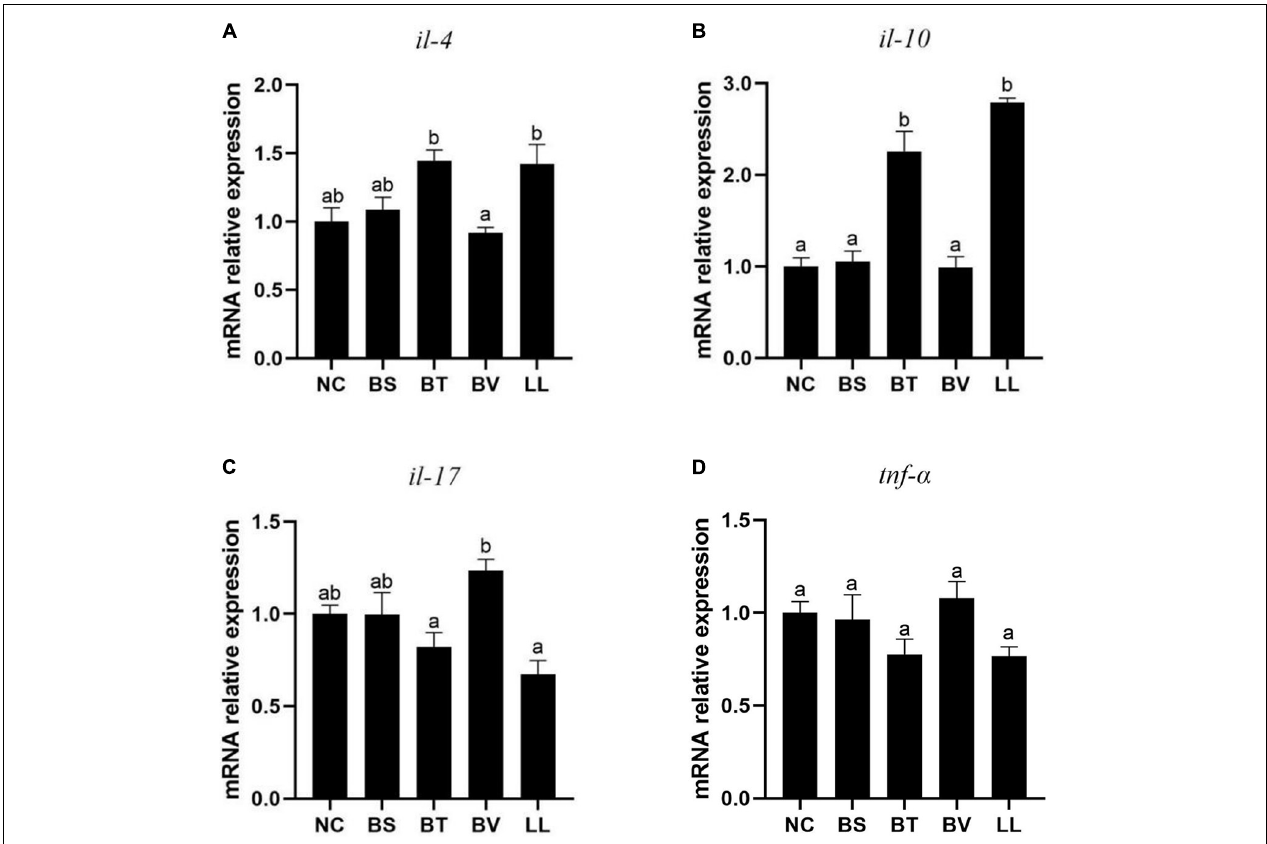
FIGURE 4 | Expression of jejunal inflammatory cytokines of bullfrog, including (A) il-4 , (B) il-10 , (C) il-17 , and (D) tnf- α . Bars with different letters were significantly different ( p < 0.05). il , interleukin; tnf , tumor necrosis factor; NC, control diet; BS, control diet containing 1 × 10 7 CFU/g of Bacillus siamensis ; BT, control diet containing 1 × 10 7 CFU/g of Bacillus tequilensis ; BV, control diet containing 1 × 10 7 CFU/g of Bacillus velezensis ; and LL, control diet containing 1 × 10 7 CFU/g of Lactococcus lactis .